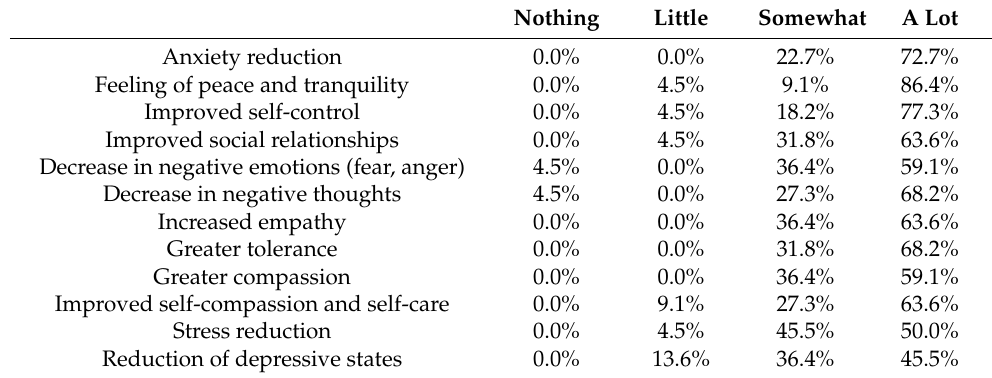
Table 3. Aspects of mental health that have been improved by the practice of mindfulness and